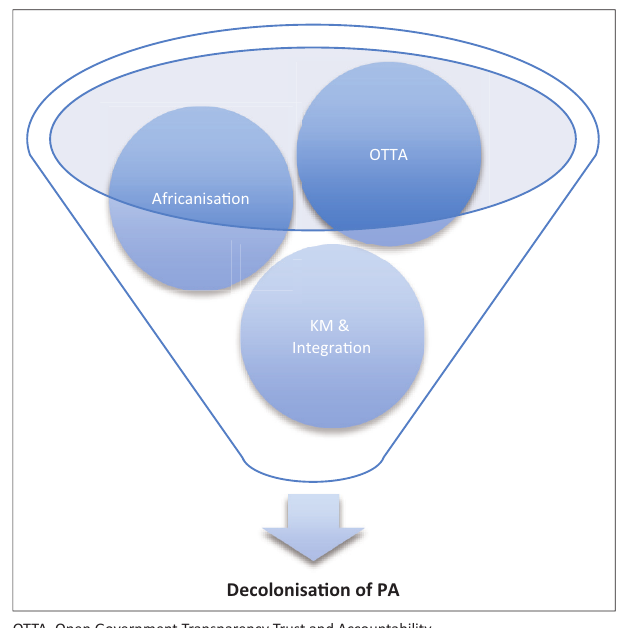
FIGURE 3: Major challenges in public administration in South